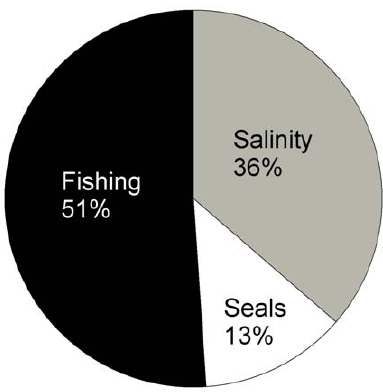
Figure 5. The relative effects of increased seal predation, a 15% decline in salinity and increased fishing up to 0.9 on projected cod spawner biomass in 2089. The fractions represent the relative contributions to the decline in biomass that is expected to occur relative to the biomass estimated assuming low seal predation, unchanged salinity and fishing mortality at